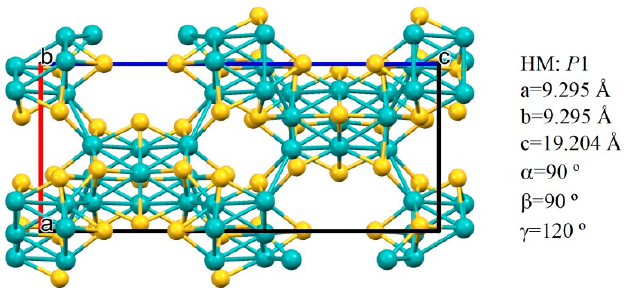
Figure 1. Mo 15 S 19 structure, viewed along b axis. Plotted with Mercury [9] using the crystallographic information file (CIF) file available from the literature [3,4].